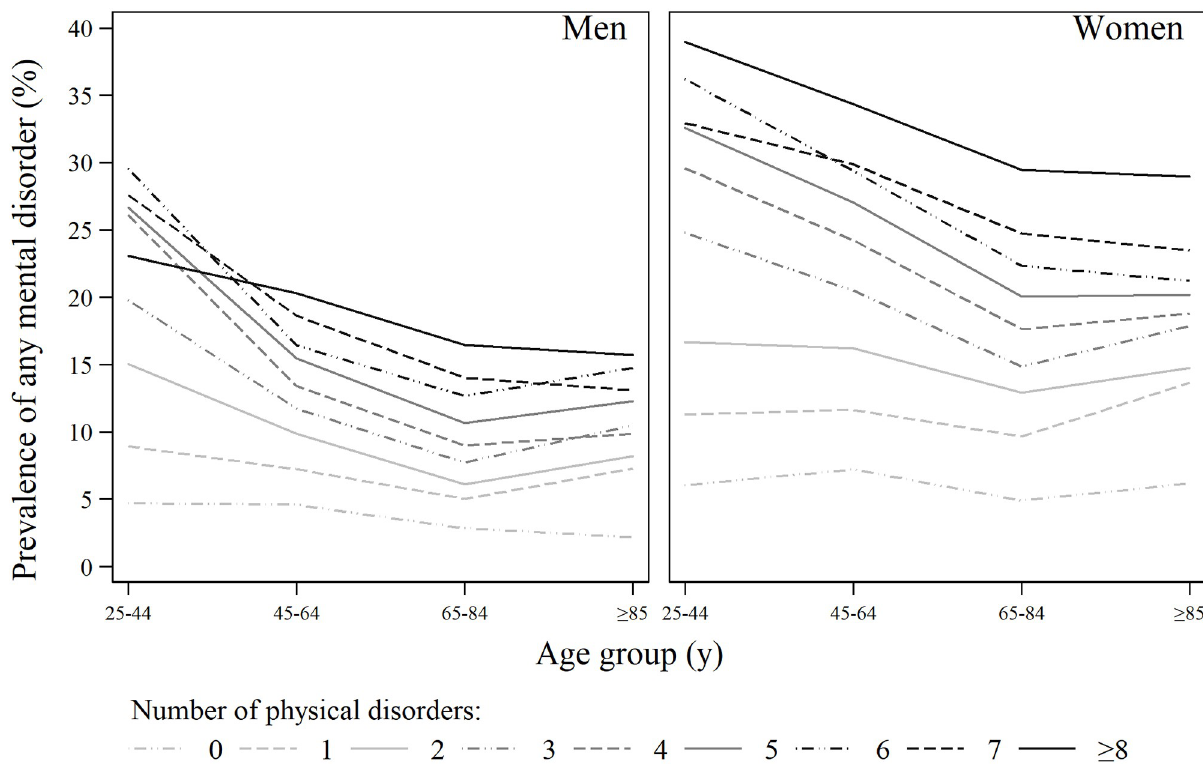
Fig 2. Prevalence of any MHD by the number of physical disorders and age groups in men and women.